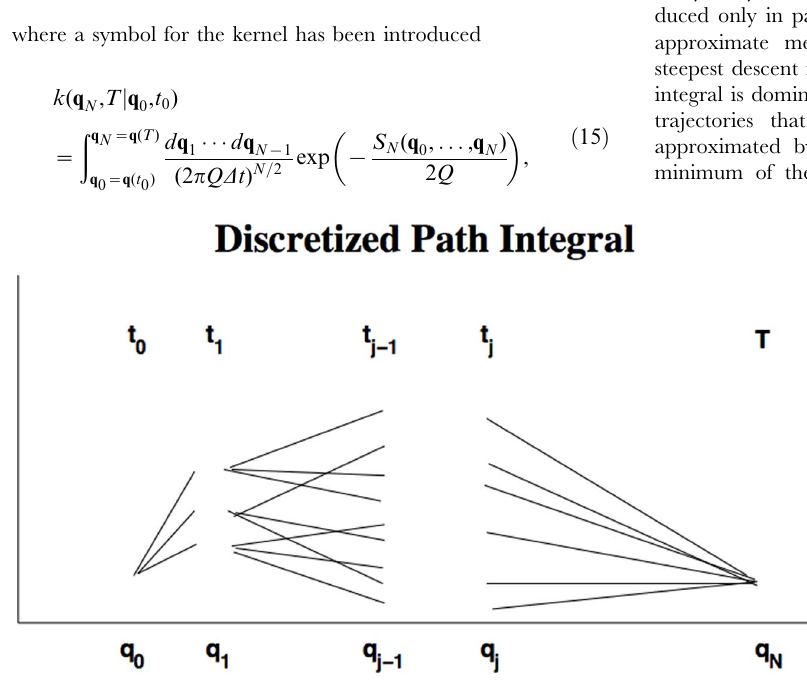
Figure 1. Discretization of the path integral. The initial q 0 and final q N variable are not integrated over.